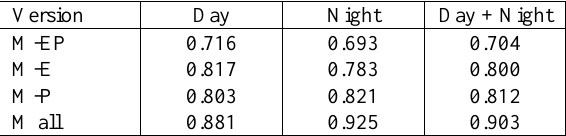
Table 1. Comparison of animal detection by precision among